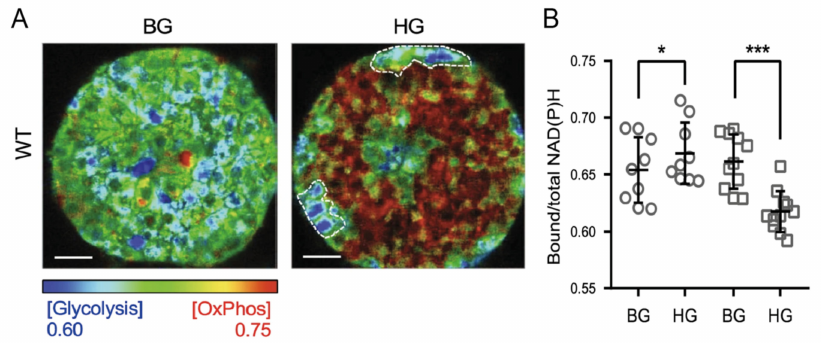
Figure 5. Phasor-FLIM analysis on murine islets. ( A ) FLIM images depicting relative glycolysis and oxidative phosphorylation in islets from a wild-type mouse islet at basal and high glucose. ( B ) Panels show bound/total NAD(P)H value for β cells and α cells, respectively, in WT mouse islets at BG and HG. Scale bar: 10 µ m. * p < 0.05, *** p < 0.001. WT, wild type; BG, basal glucose (4mM); HG, high glucose (16mM). Adapted from Wang et al.